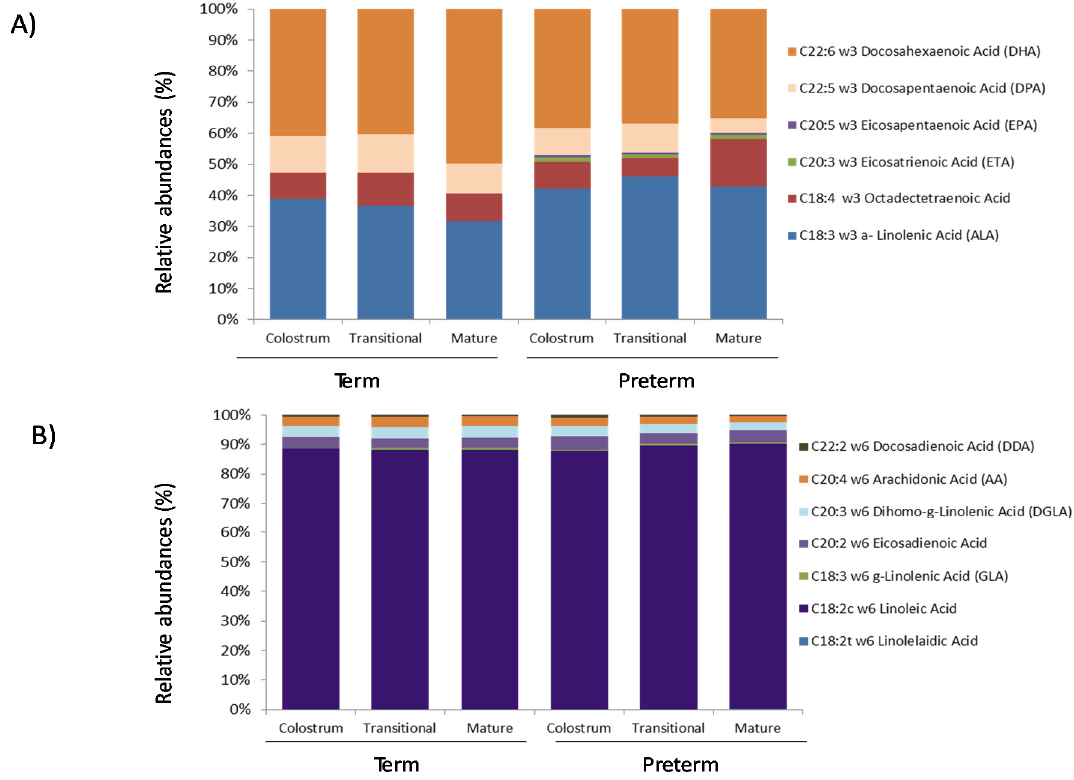
Figure 3. Relative abundances (%) of different PUFAs omega 3 family components (Panel A) and omega ‐ 6 family components (Panel B) present in breast milk samples analysed by gas chromatography and grouped according to gestational age and lactation stage.